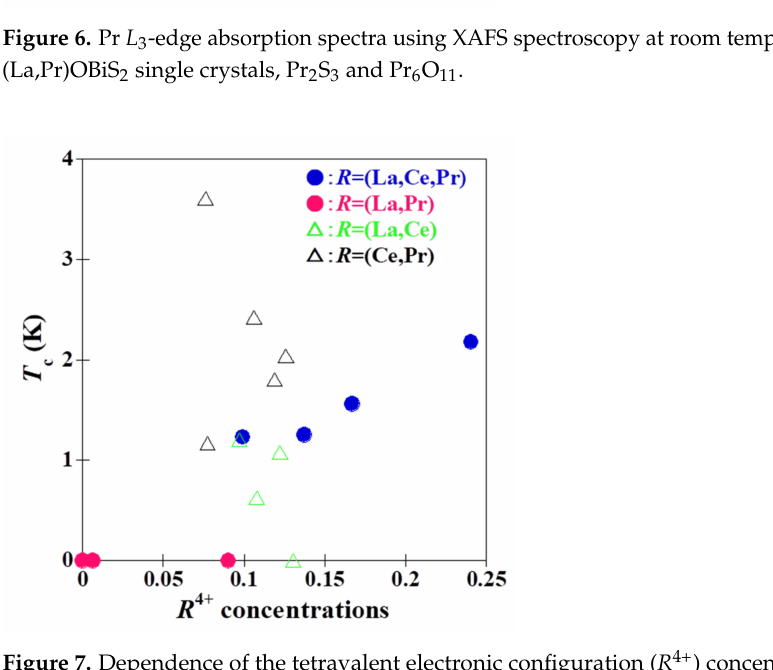
Figure 7. Dependence of the tetravalent electronic configuration ( R 4+ ) concentrations on T c for the binary and ternary R OBiS 2 single